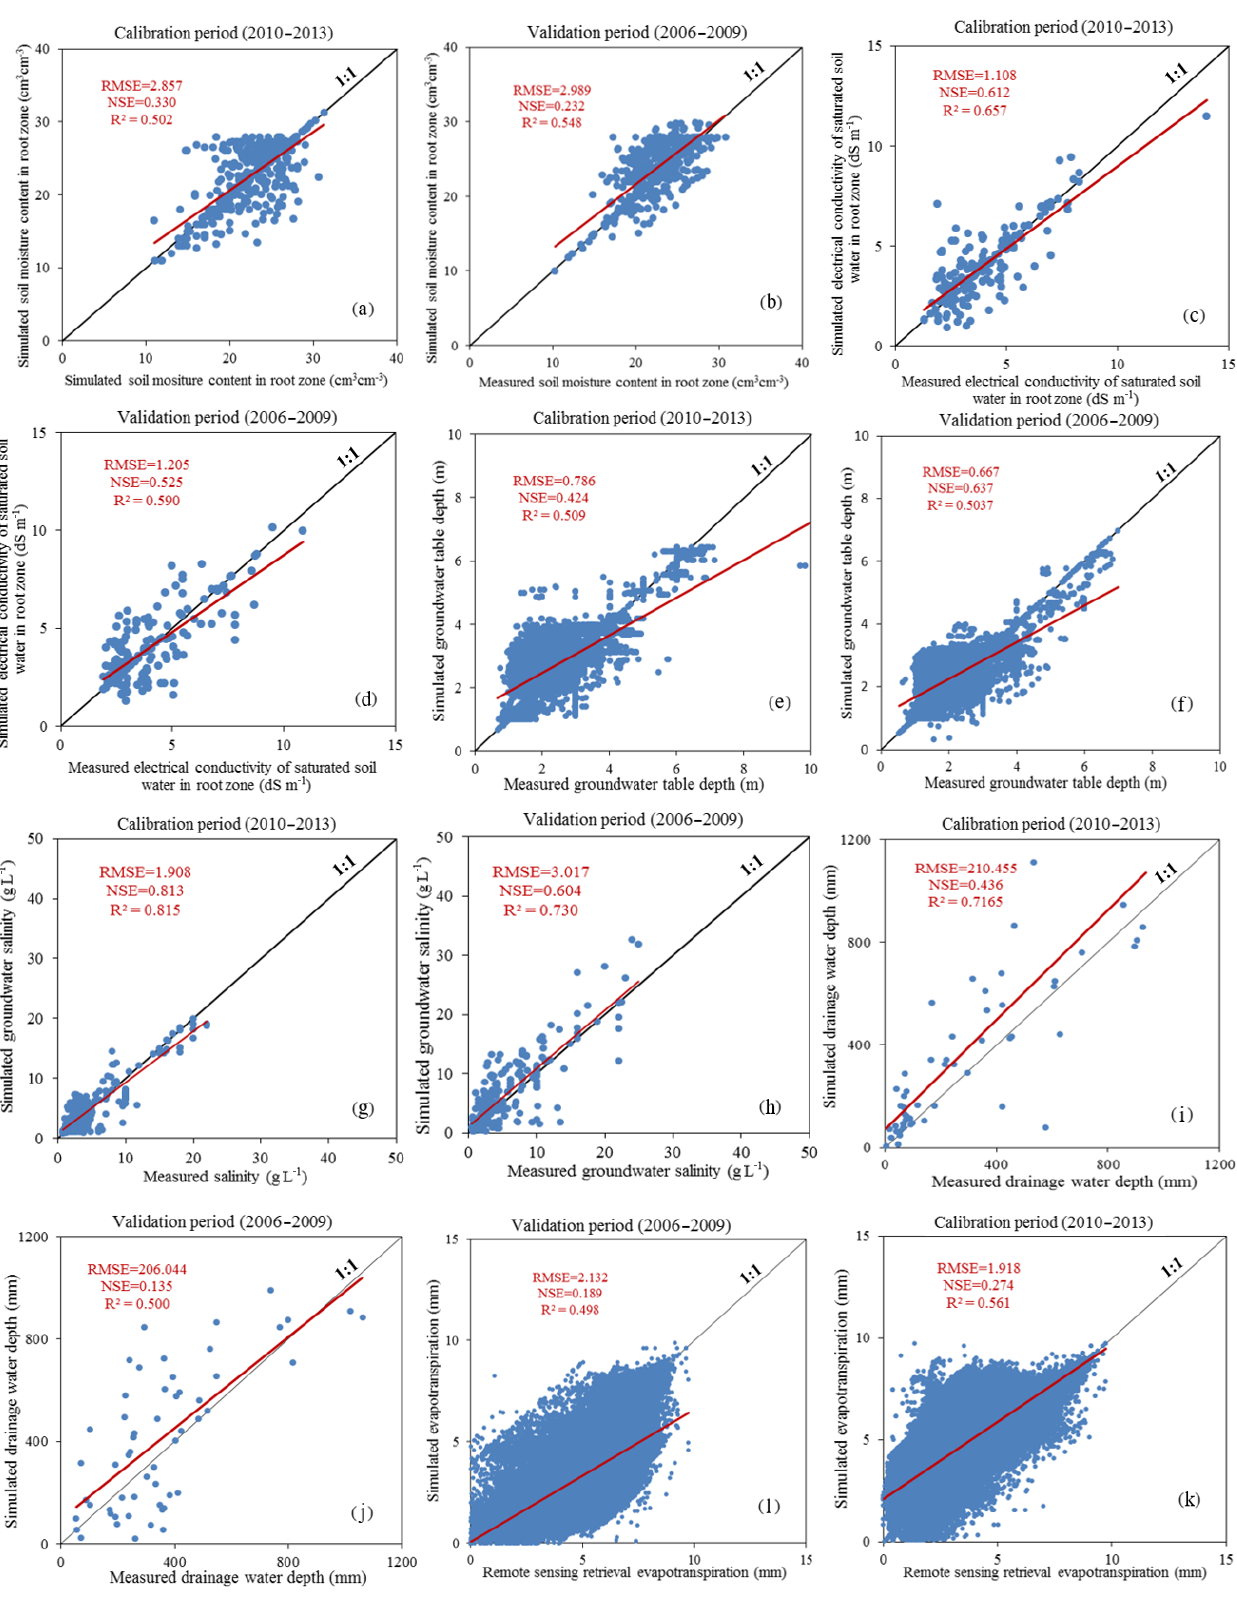
Figure 6. Relationship between the simulated and measured values during the crop growing season in the calibration and validation periods,